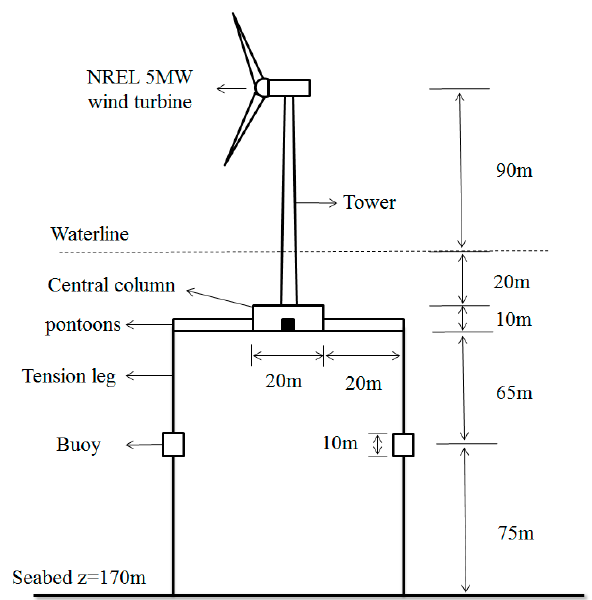
Figure 1. Sketch map of the Serbuoys-TLP concept system.